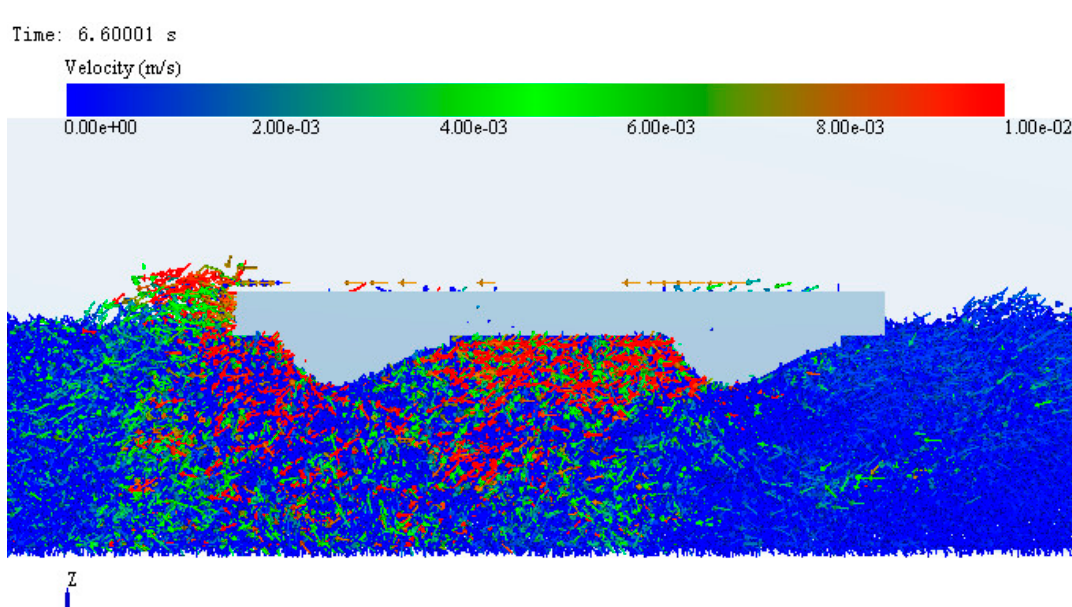
Figure 13. Particle flow field under bionic track shoe.